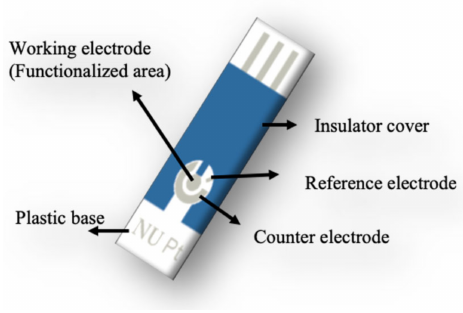
Figure 2. Microfabrication of sensor chip.